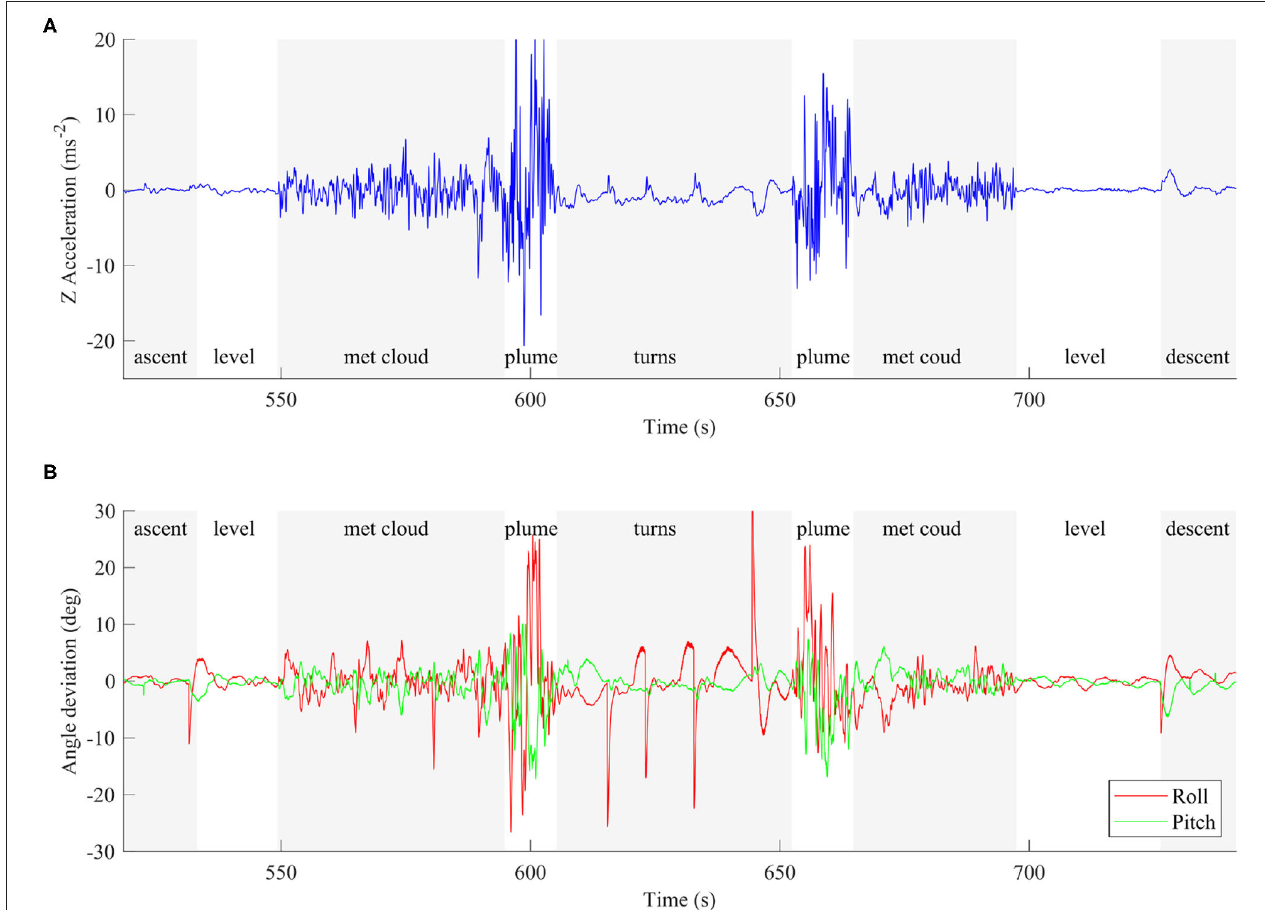
FIGURE 6 | (A) The body Z axis accelerations during Flight A. Note the difference in turbulence experienced by the aircraft as it encounters the various air conditions. (B) The roll and pitch deviations calculated as the difference between the orientation and its target. Larger values indicate the vehicle has been perturbed further from its trimmed